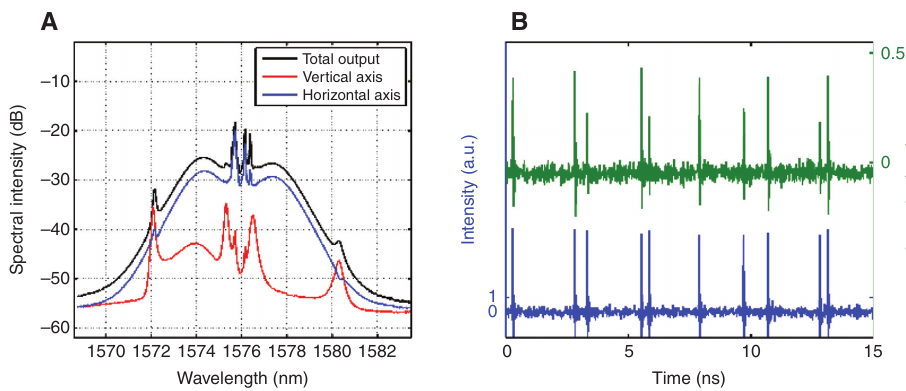
Figure 7: Dual-wavelength, vector-induced, gain-guided dissipative soliton operation of the fiber laser. (A) Polarization-resolved optical spectra. (B) Polarization-resolved oscilloscope